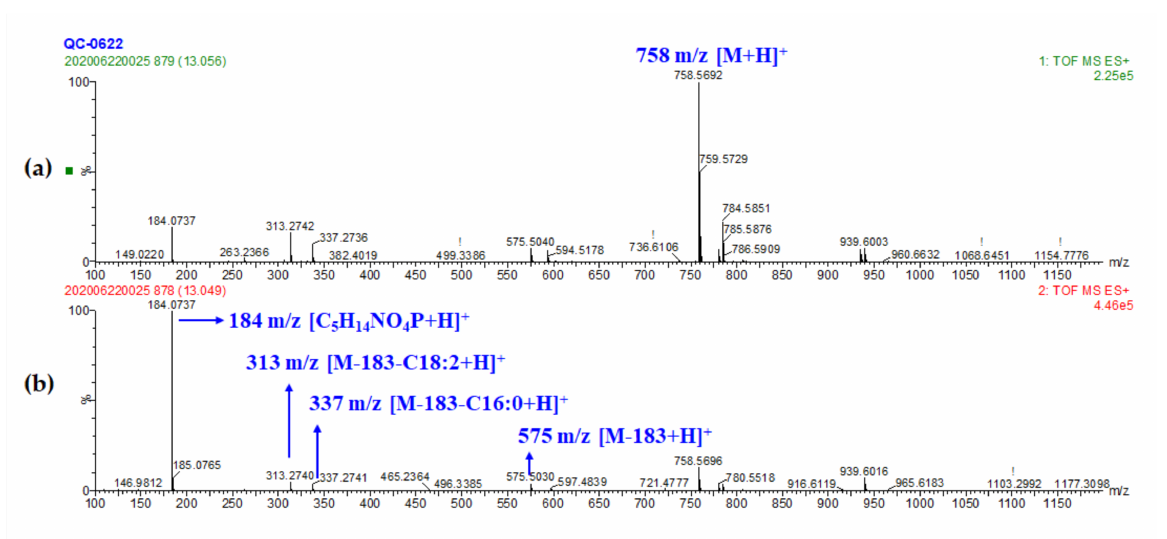
Figure 2. MS spectra of PC (16:0/18:2). (peak 25) ( a ) MS 1 spectrum and ( b ) MS 2 spectrum.